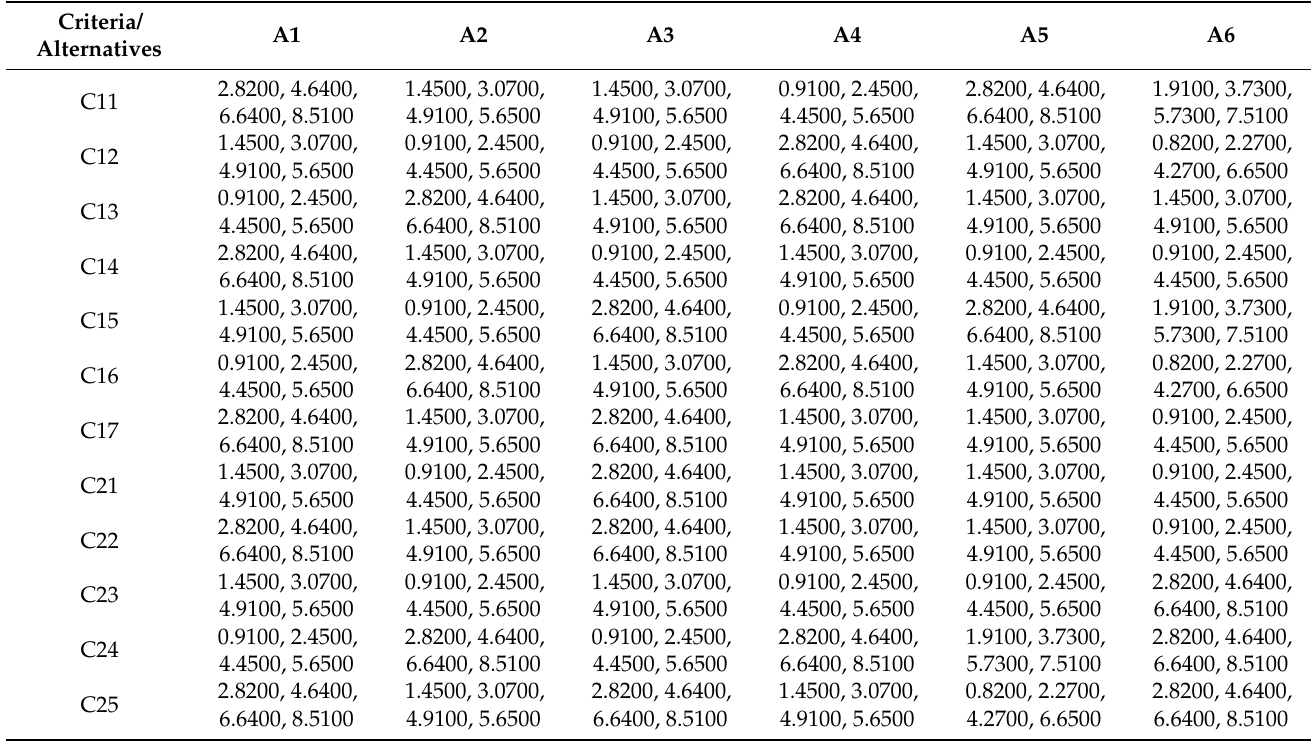
Table 6. Subjective Cognition Outcomes.